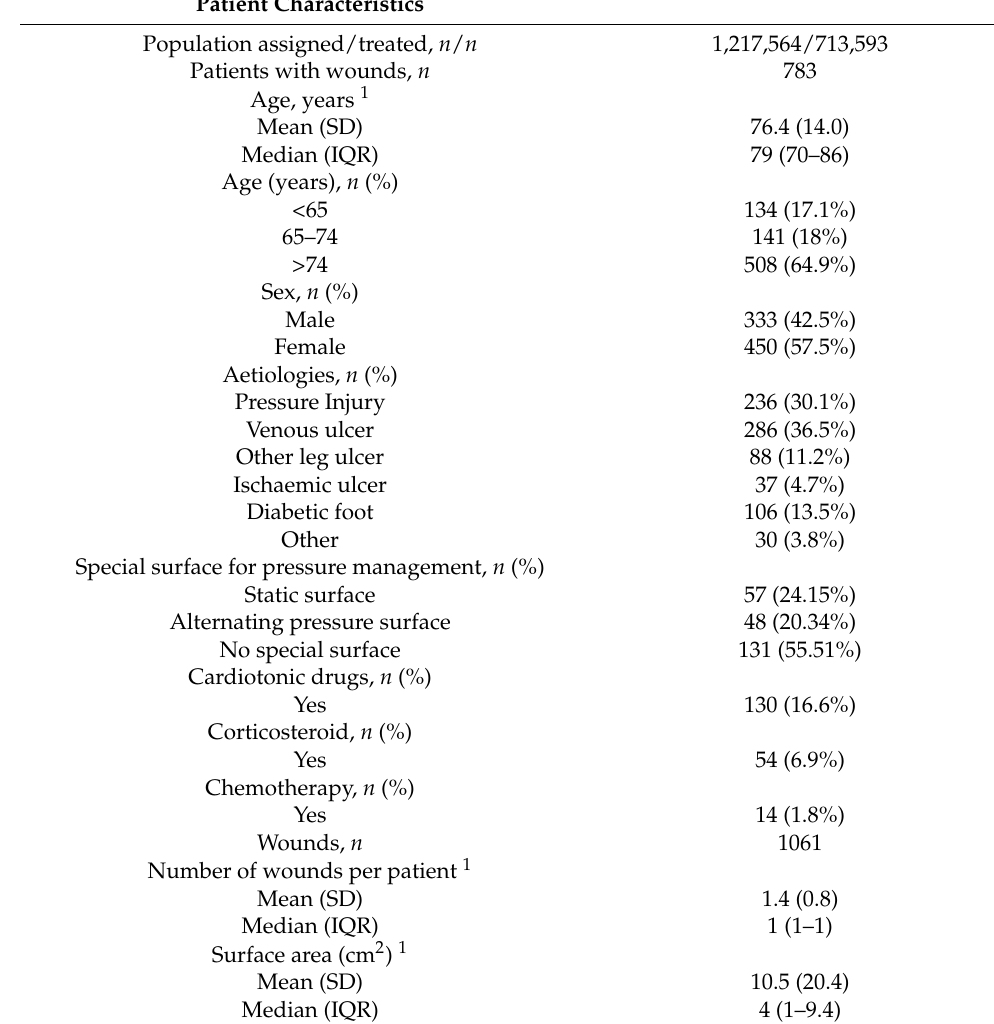
Table 1. Patient